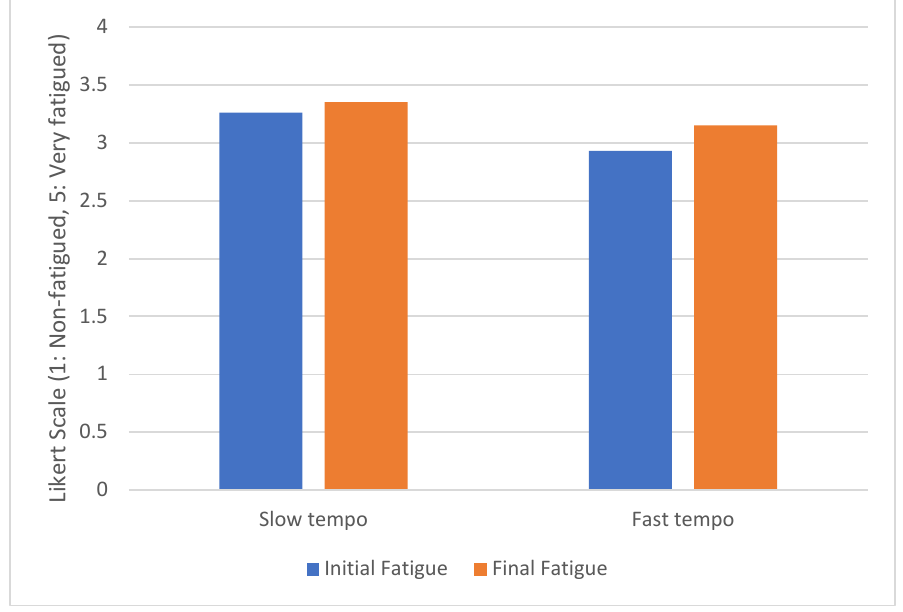
Figure 11. Fatigue evolution grouped by music tempo.